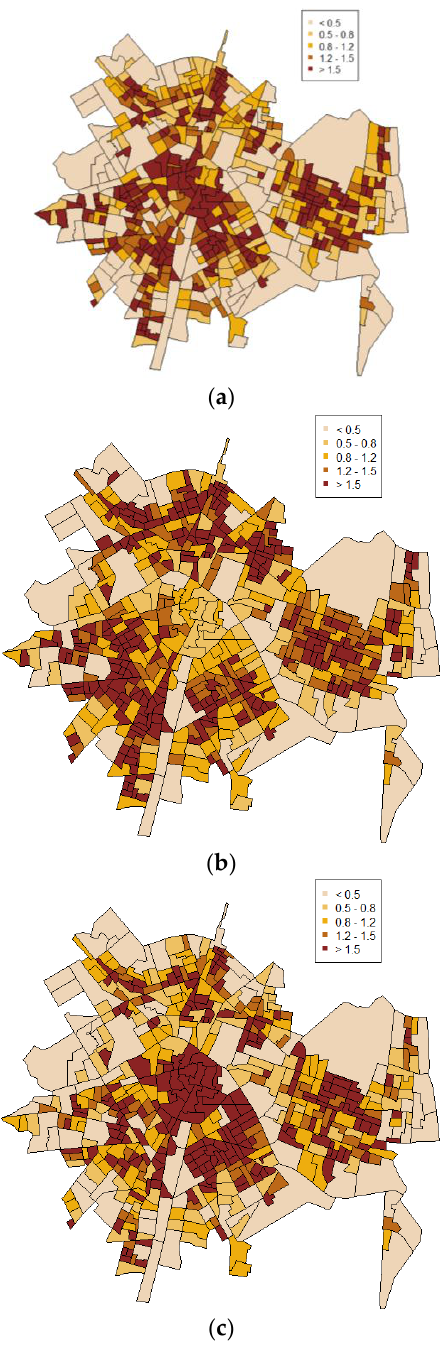
Figure 2. ( a ) Off-premise density in 2015; ( b ) restaurant/cafe density in 2015; and ( c ) bar density in 2015.